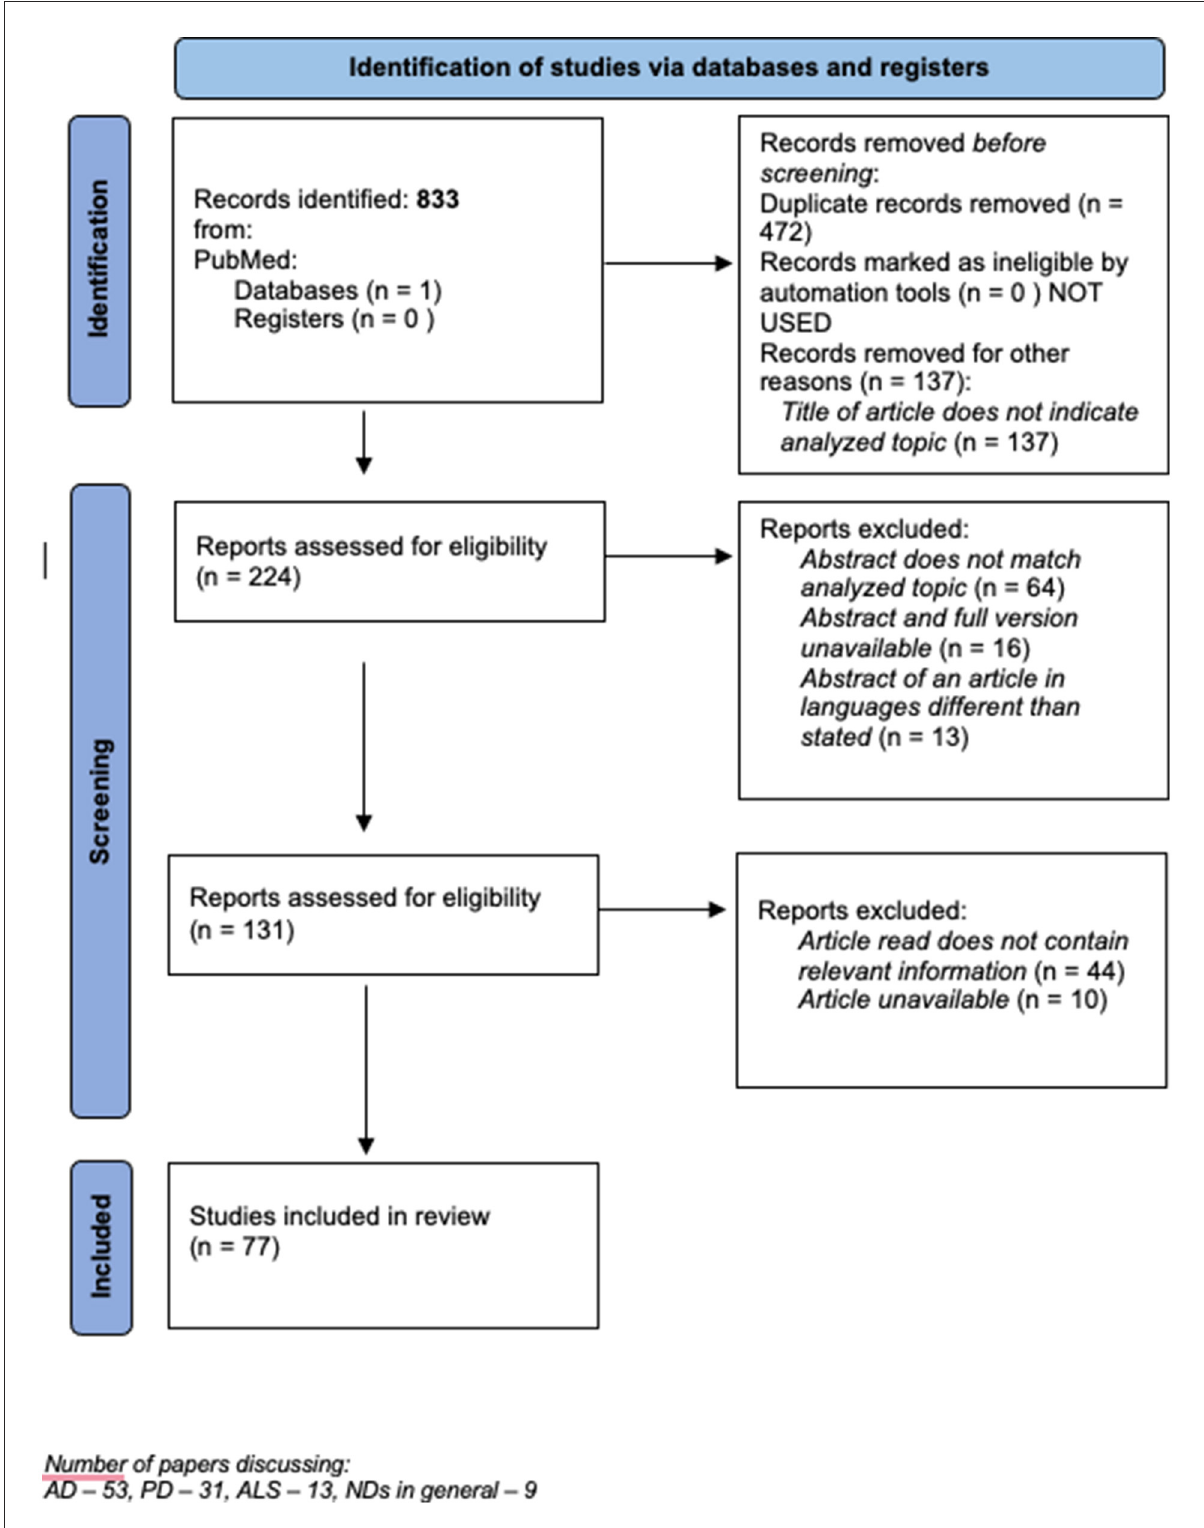
FIGURE1 The method of the search strategy. Number of papers discussing : AD = 53, PD = 31, ALS = 13, NDs in general = 9.